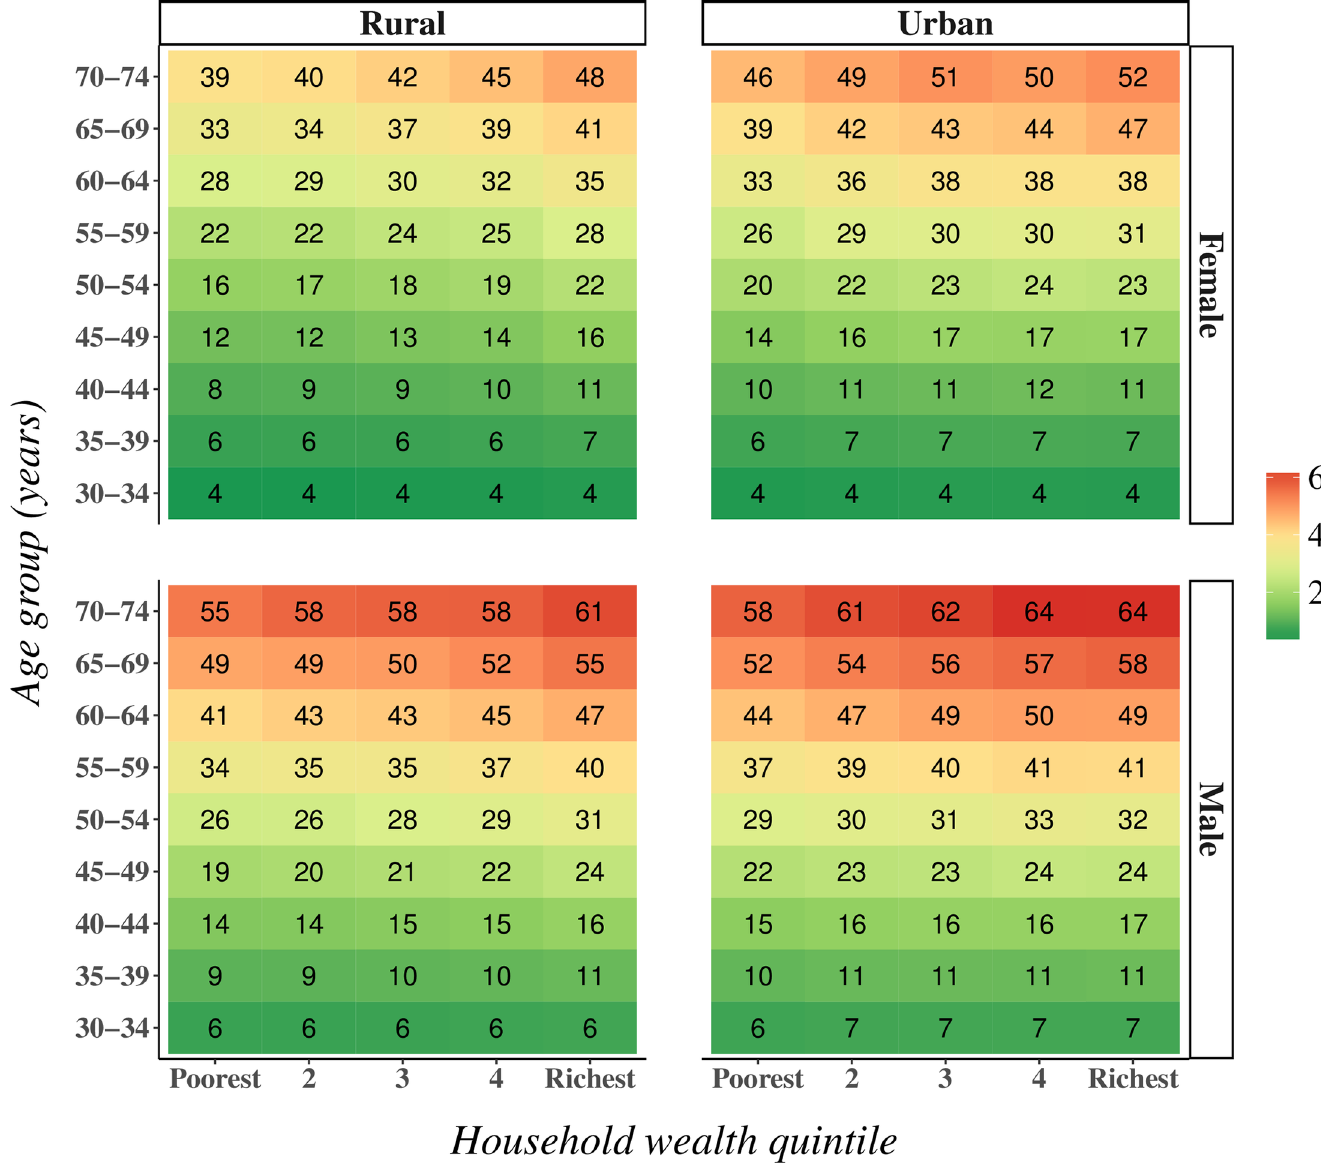
PLOS Medicine| https://doi.org/10.1371/journal.pmed.1002581 June 19,